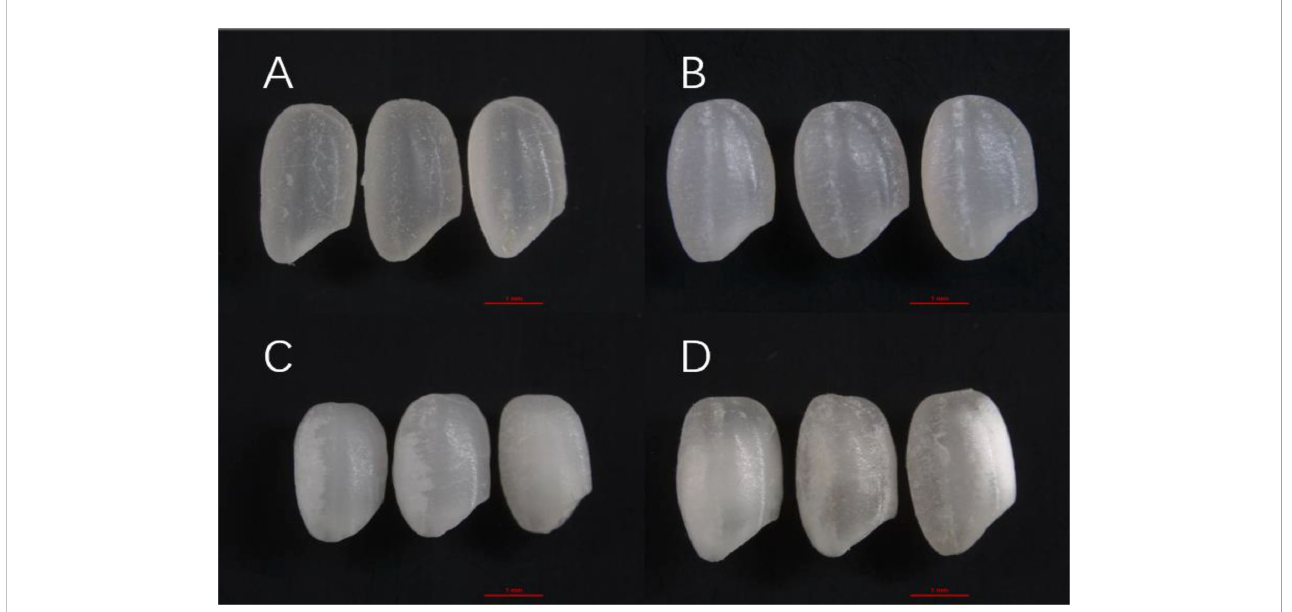
FIGURE 1 Images of rice grains from a stereo microscope: (A) Y28, (B) N5718, (C) W113 and (D) Y5118. The red line in Figure 1 is a scale representing one millimeter in